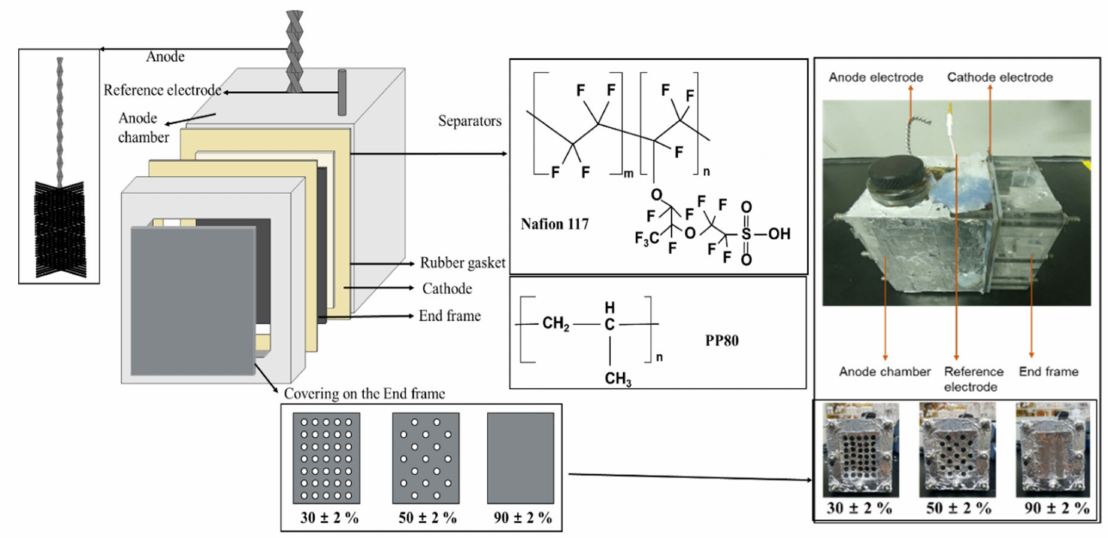
Figure 1. Exploded schematic view and photograph of a single chamber the air-cathode microbial fuel cell (MFC) with an end frame for controlling relative